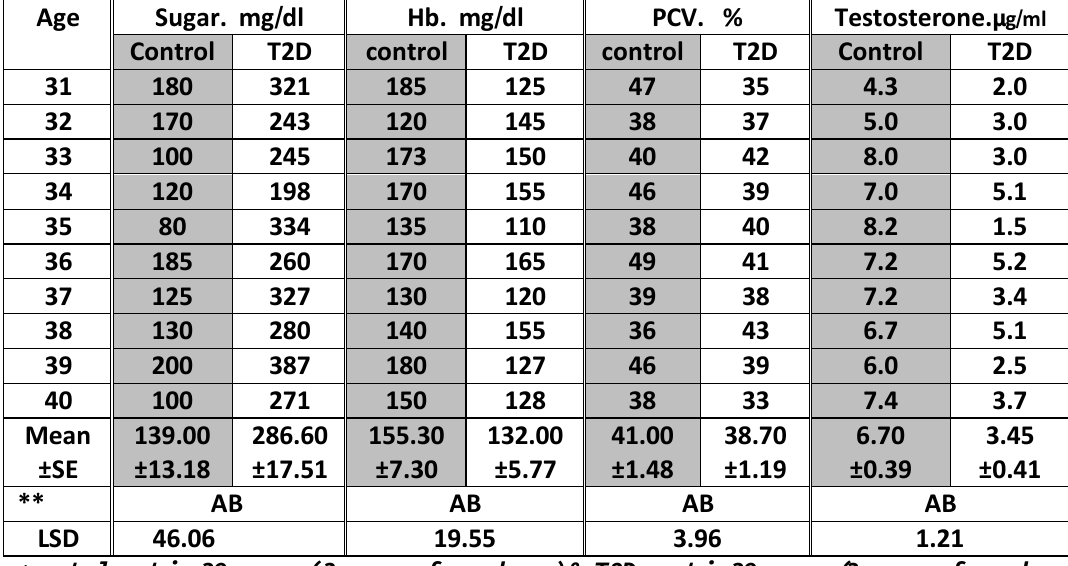
Table (1):Group A: age {31-40} years: Sugar , PCV, Hb & Testosterone level in both (control and T2D) * .